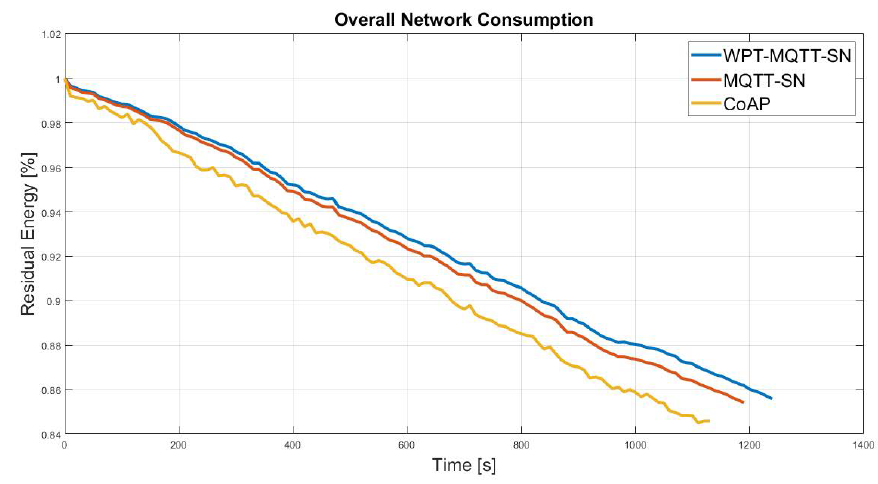
Figure 12. Normalised average residual battery level achieved by the CoAP, MQTT-SN and WPT- MQTT-SN protocols in a Two-Tier star based topology nodes deployment.